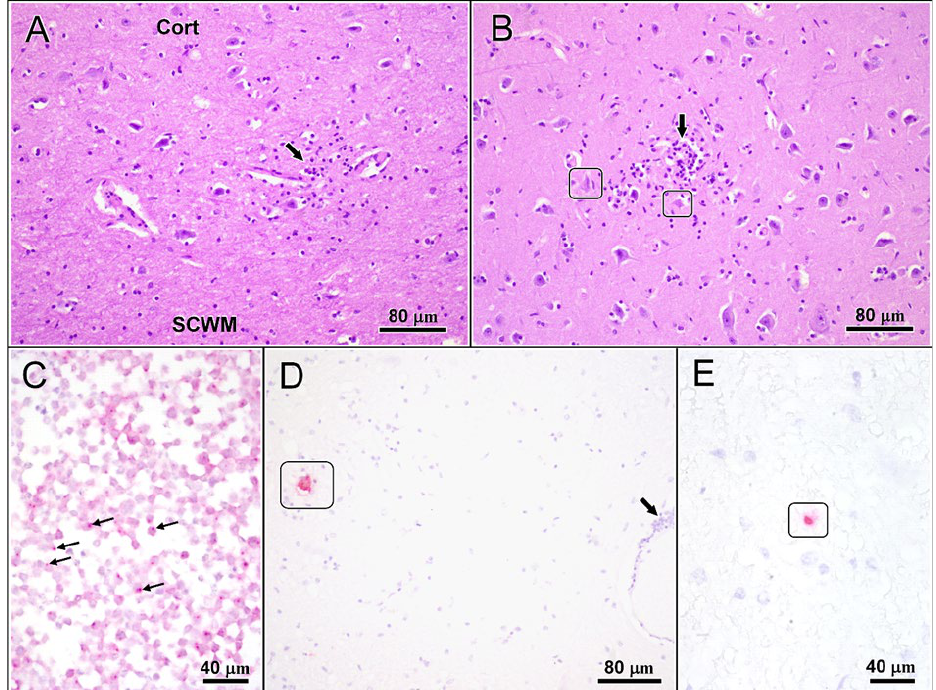
Figure 1. (panels A – E ): Brain changes of TBEV-infected 15-year-old haflinger gelding. ( A , B ): Histo- logical changes comprise multifocal lymphohistiocytic infiltration and microgliosis (arrows) scattered throughout grey matter of cortices ( A ) and nuclei ( B ). The infiltrates are occasionally associated with nerve cell degeneration (frames) and neuronophagia (not shown) indicating cytopathic activity of the virus. ( C , D , E ): Viral RNA has been visualized using RNA Scope ® technology in infected HeLa cells ( A : small arrows), used as the positive control, and in affected brains ( D , E ). At this stage of infection, the yield of viral RNA flags up in individual pyramidal ( D : frame) and granule neurons ( E : frame) only, even distant from other tissue changes such as lymphocytic perivascular infiltrates (Barrow). Cort: cortex; SCWM: subcortical white matter. Stains/chromagens: ( A , B ): haematoxilin-eosin; ( C , D , E ): haematoxilin (blue)/AEC (red).